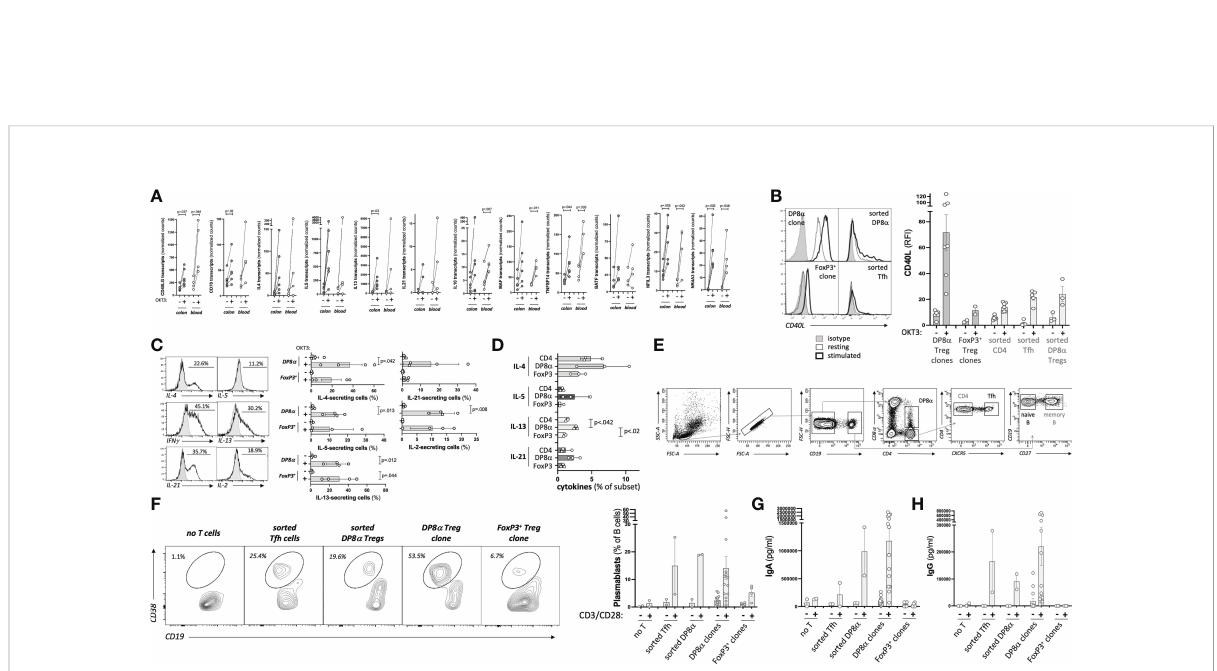
FIGURE 5 Blood-derived DP8 a Tregs promote IgA-secreting B cell differentiation. (A) Expression by DP8 a Treg clones of transcripts involved in B cell help. (B) CD40L: representative histogram plots examples (left) and RFI for all tested cell types (right). (C) Cytokine production by DP8 a clones: representative histogram plots examples (left) and all clone data (right) are shown. (D) PBMCs from 3 HD were OKT3-stimulated and stained for indicated cytokines. (E) Gating strategy used for the sortings of T and B cell subsets. (F - H) Sorted naïve B cells were co-cultured with autologous indicated CD4 + T cell subsets or Treg clones (ratio 1:1). Plasmablast frequency was assessed 10 days later (F) . Supernatants were tested for total IgA (G) and IgG (H) contents. Paired 2-sided t-tests were used for single comparisons, while one-way ANOVA followed by Dunn ’ s multiple comparison tests were performed for 5D, p<.05 was considered statistically signi fi cant.